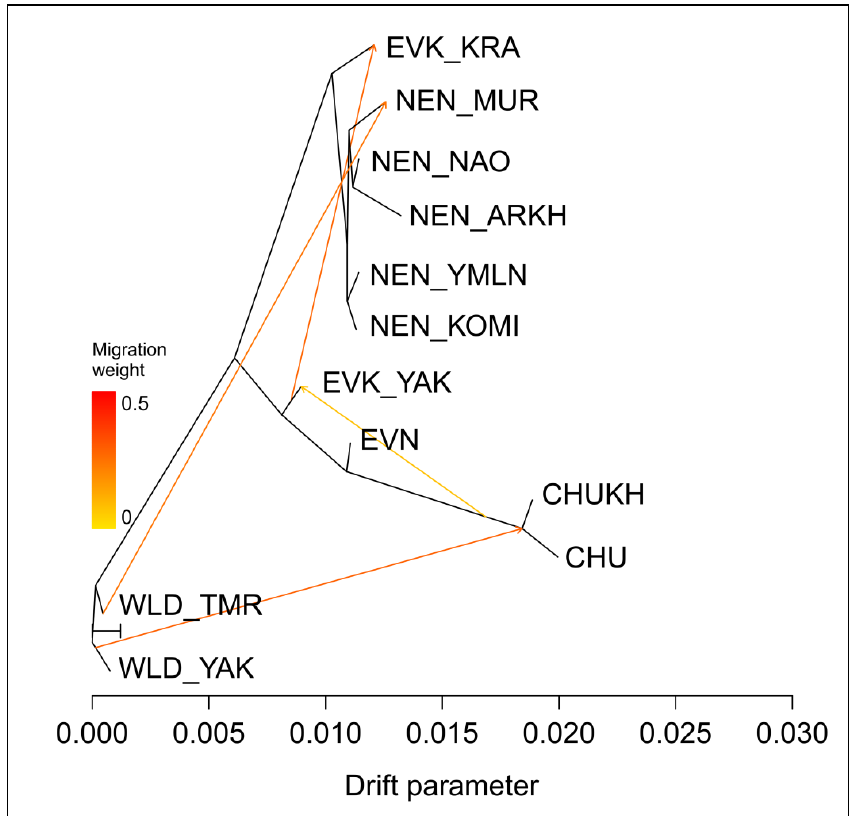
Figure 3. Maximum likelihood tree produced by TreeMix with four migration edges. 1 CHU,